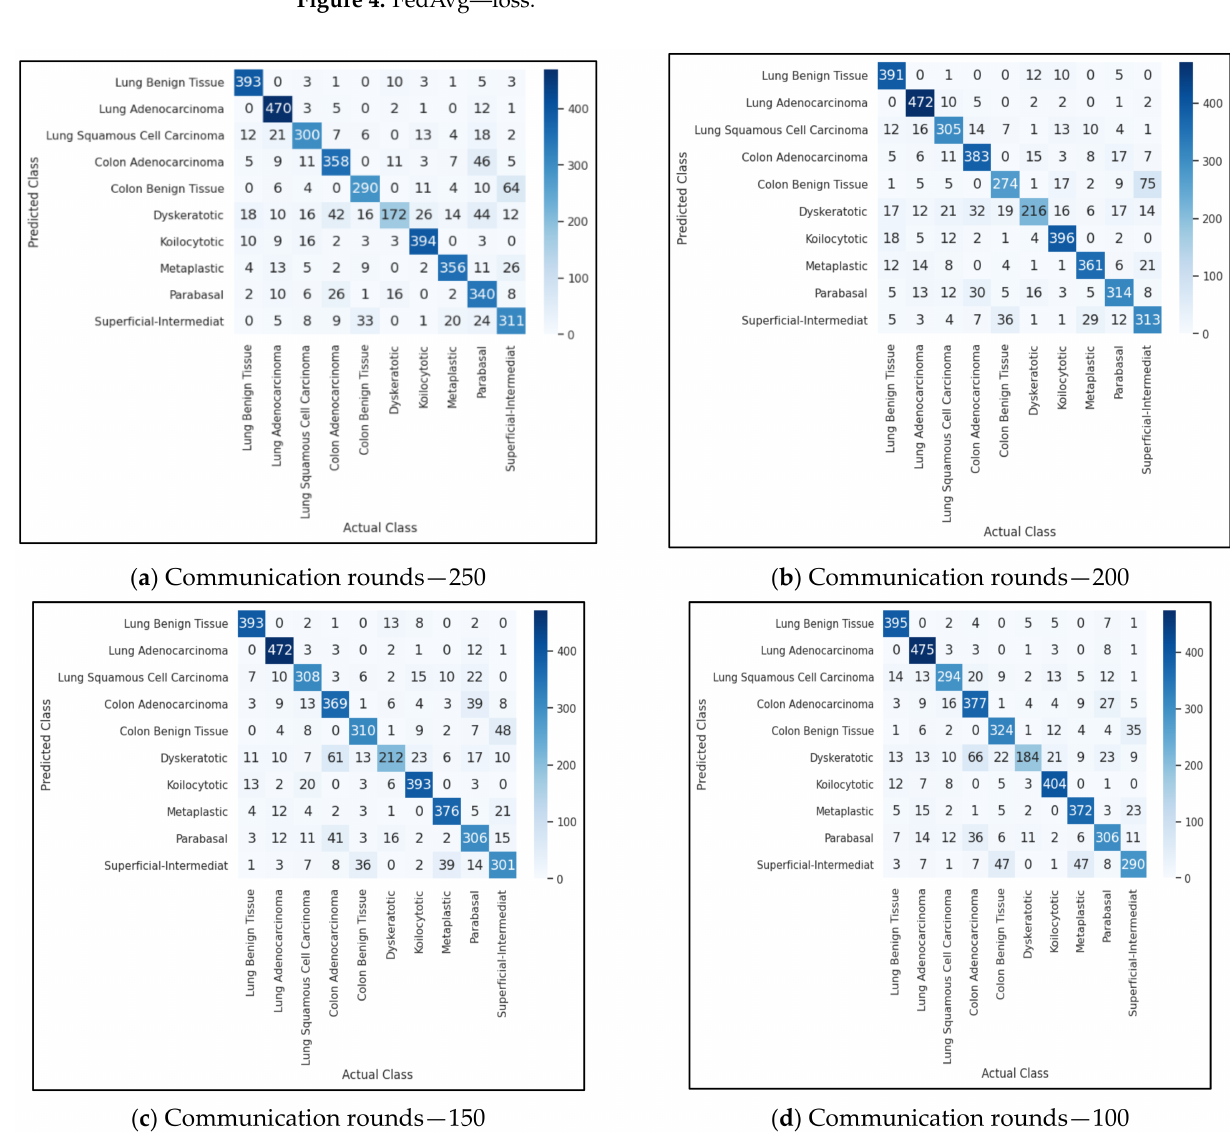
Figure 5. FedAvg—confusion